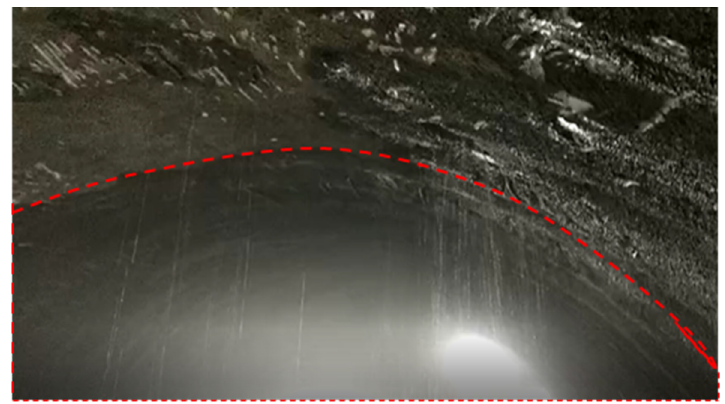
Figure 3. Sprinkling water seepage in tunnel vault.